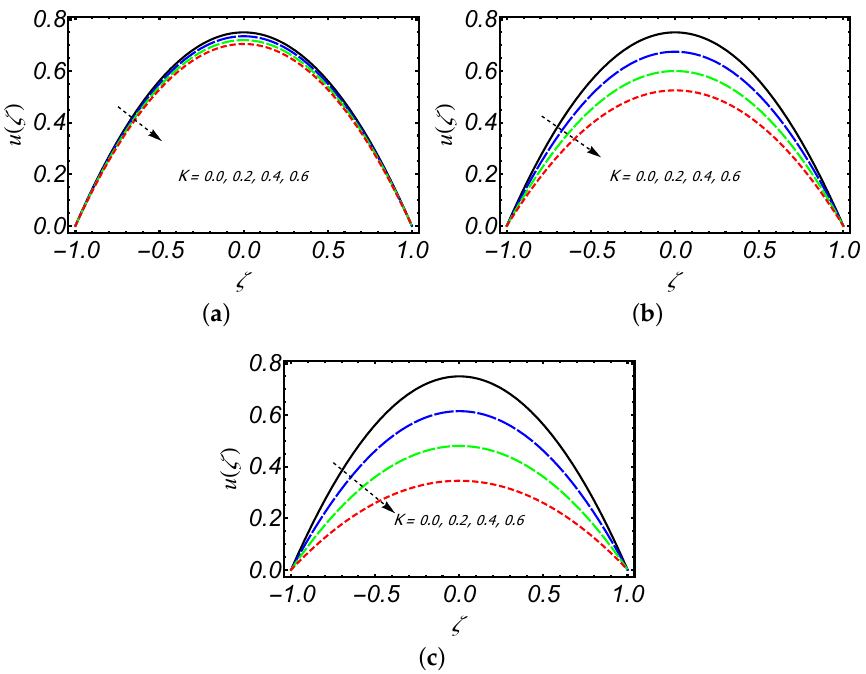
Figure 2. Behavior of u ( ζ ) with K at ( a ) x = 0.1, ( b ) x = 0.5, ( c ) x = 0.9, when φ = δ = 0.0.